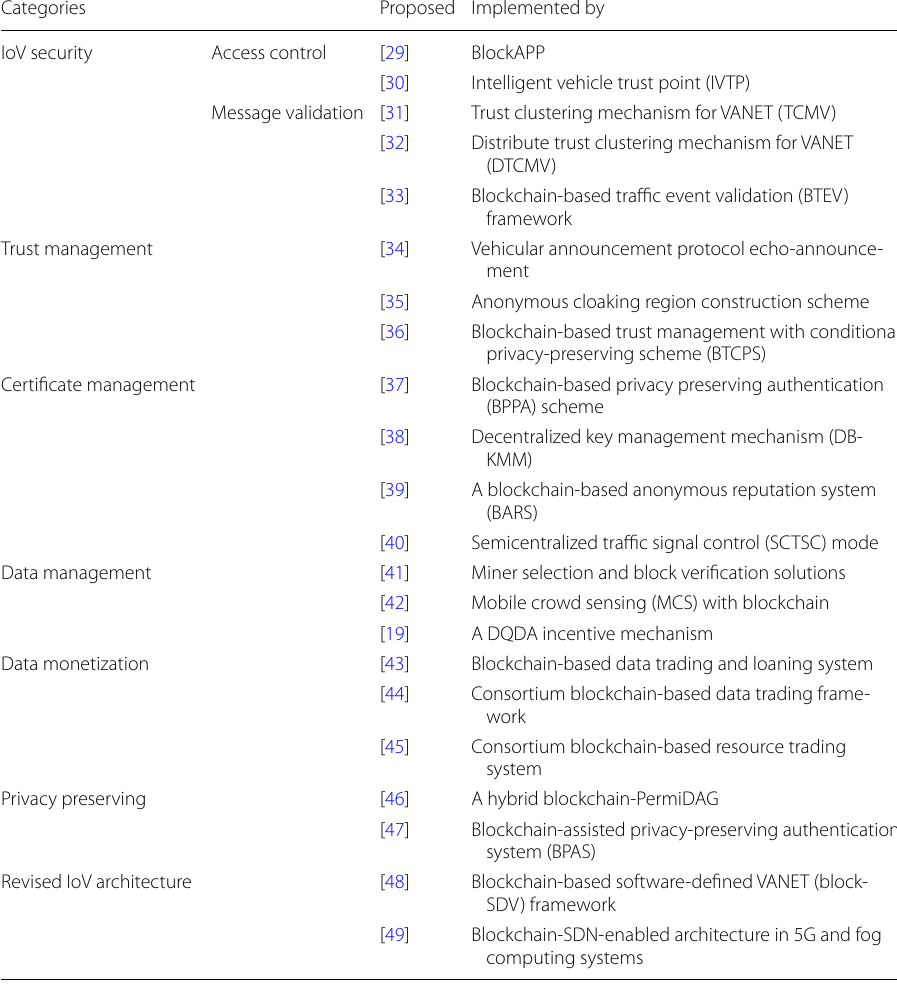
Table 2 Integration of the blockchain and the IoVs